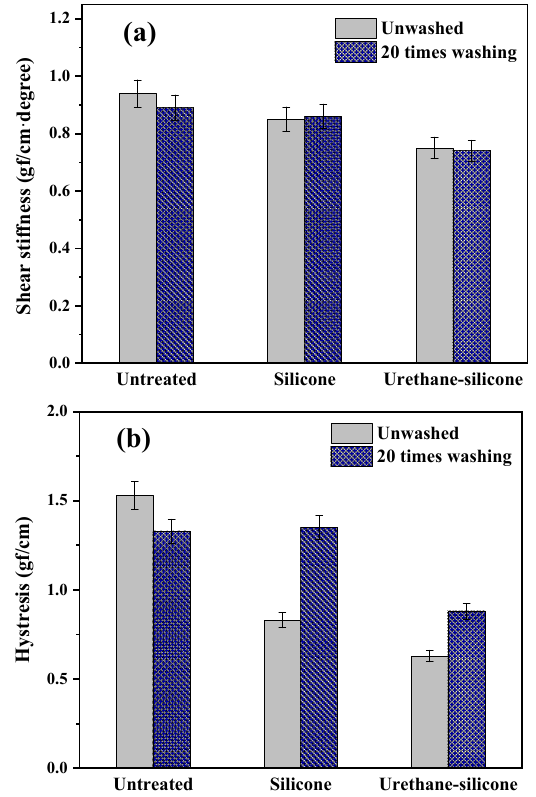
Figure 9. Shear properties of the cotton knit fabric untreated and treated with softeners. ( a ) Shear stiffness; ( b ) hysteresis.